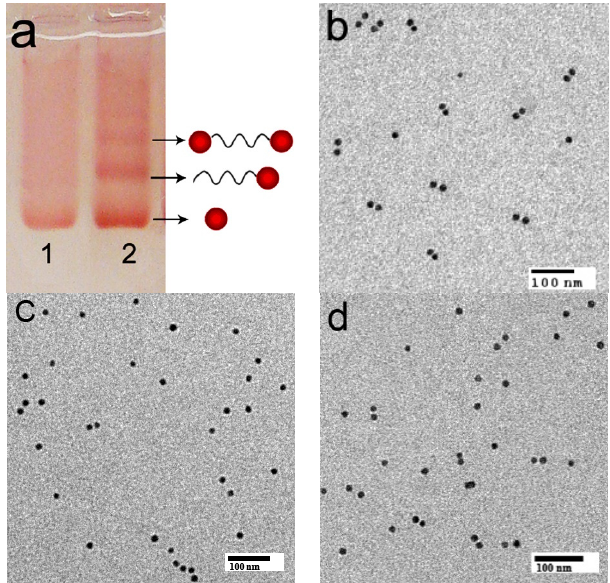
Figure 1. Characterization of discrete DNA-AuNP conjugates: ( a ) Electrophoretic analysis (2.5% agarose gel) of ssDNA-bridged AuNP dimers formed from molecular beacon sequences with 15 nm AuNPs. Lane 1: Bare AuNP, as a reference; Lane 2: A mixture of AuNP with the two cyclic disulfide–modified DNA strands. ( b ) Typical transmission electron microscopy (TEM) image of AuNP dimers separated by agarose gel electrophoresis. ( c ) Typical TEM image of AuNP-DNA separated by agarose gel electrophoresis. ( d ) Typical TEM image of AuNP dimers produced by the traditional hybridization method with two complementary AuNP-DNA conjugates.